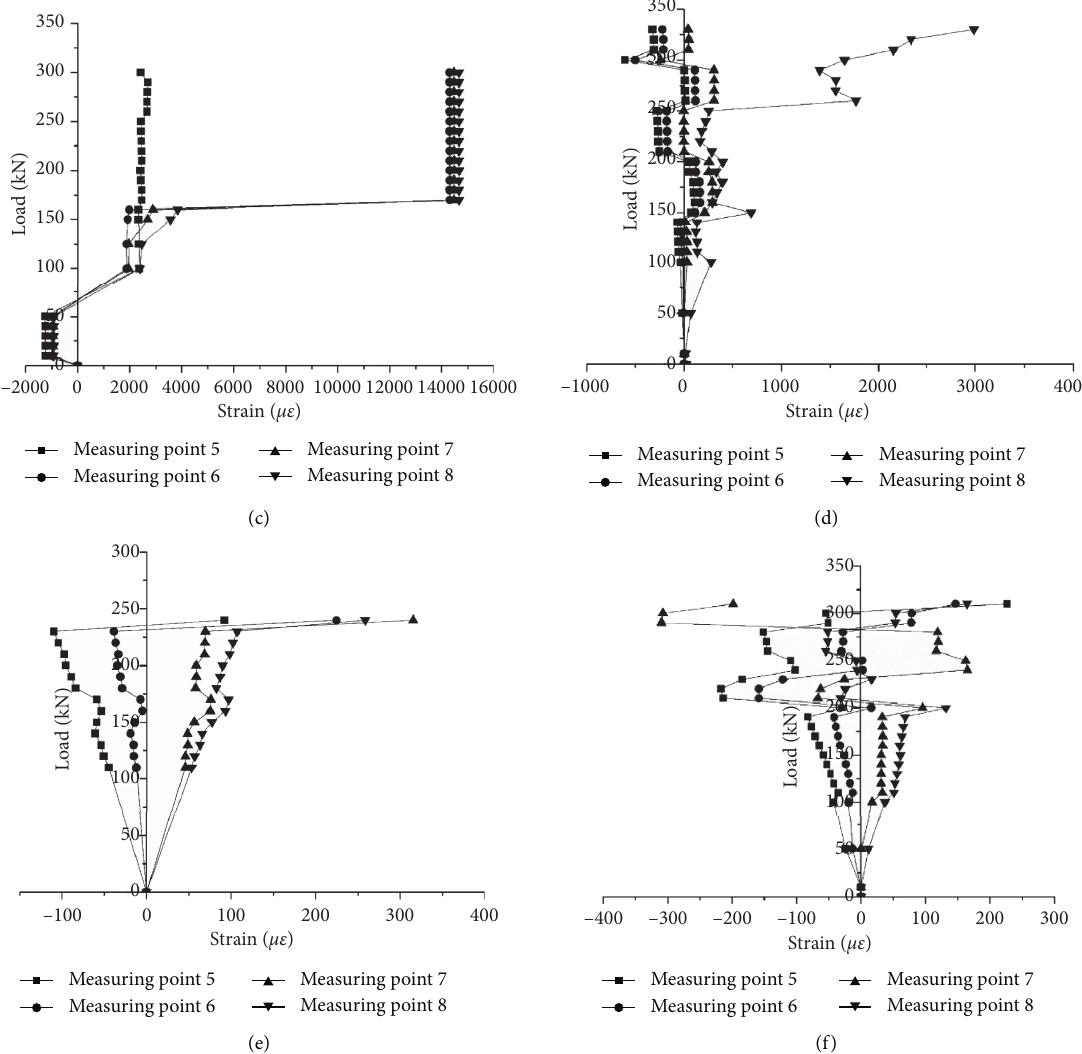
Figure 12: Strain-load curves for each measuring point on the side of the specimens: (a) SP1, (b) SP2, (c) SP3, (d) SP4, (e) SP5, and (f)